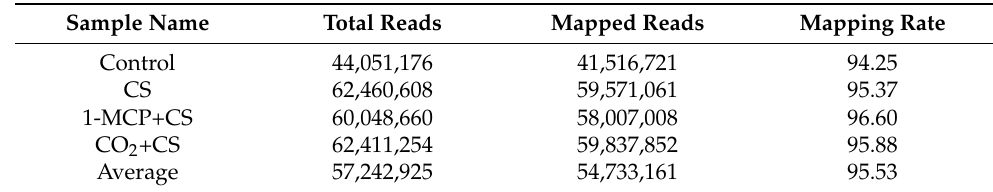
Table 1. Summary of the mapping rate at which readings for each peach sample are mapped to the reference